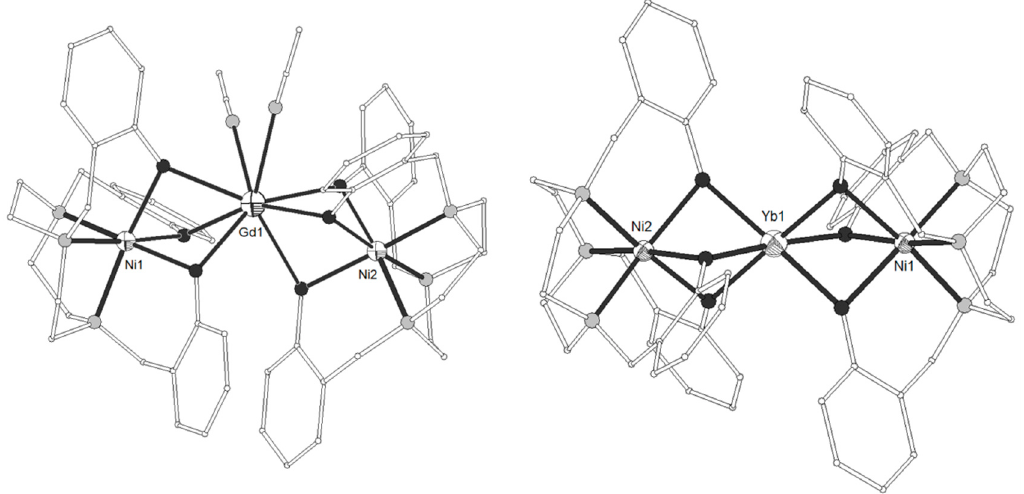
Figure 5. The molecular structures of the cations [(NiL 8 ) 2 Gd(MeCN) 2 ] + 54 , ( left ) and [(NiL 8 ) 2 Yb] + 56 , ( right ). Color code as in Figure 2 [27].